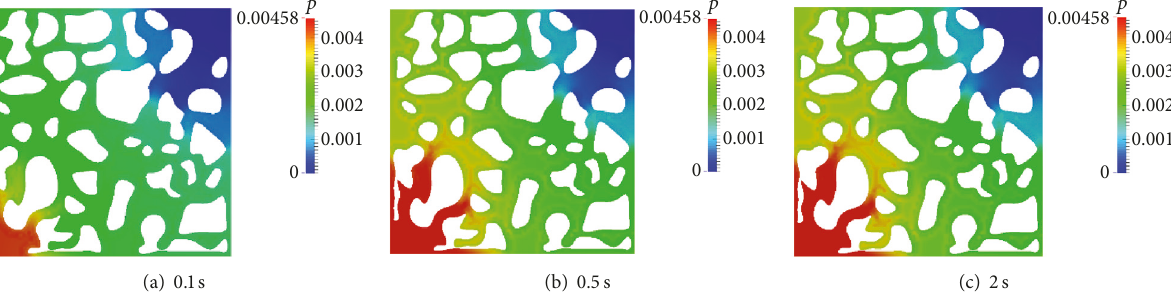
Figure 5: The pressure distribution diagram of the polymer solution injected at different times ( 𝜆 = 0.06 s).